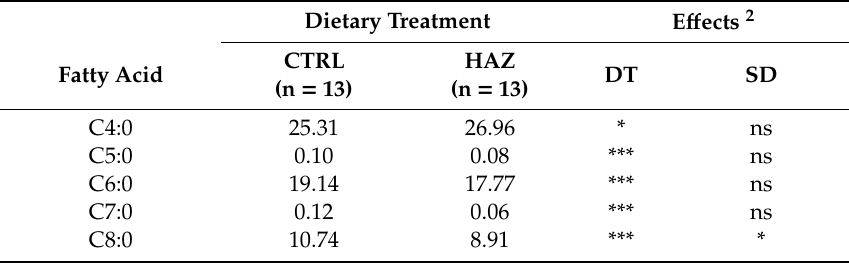
Table 4. Saturated and branched-chain fatty acids (g / kg fat) in milk of cows fed the control (CTRL) and hazelnut skin (HAZ) diets 1